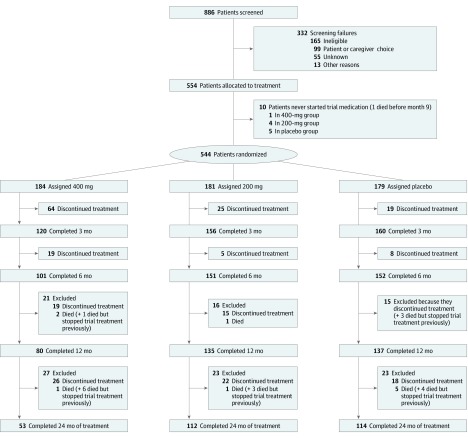
Flowchart of Study